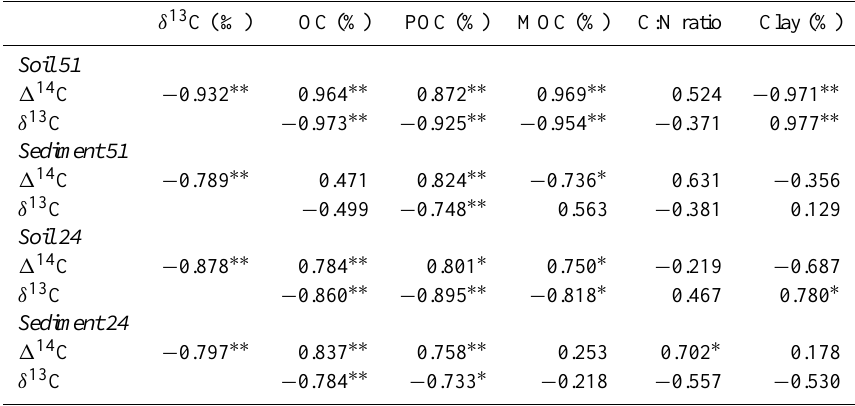
Table 5. Correlation coefficients between δ 13 C, 1 14 C and selected variables (Spearman’s rho reported) ∗ p < 0 . 05, ∗∗ p < 0 .